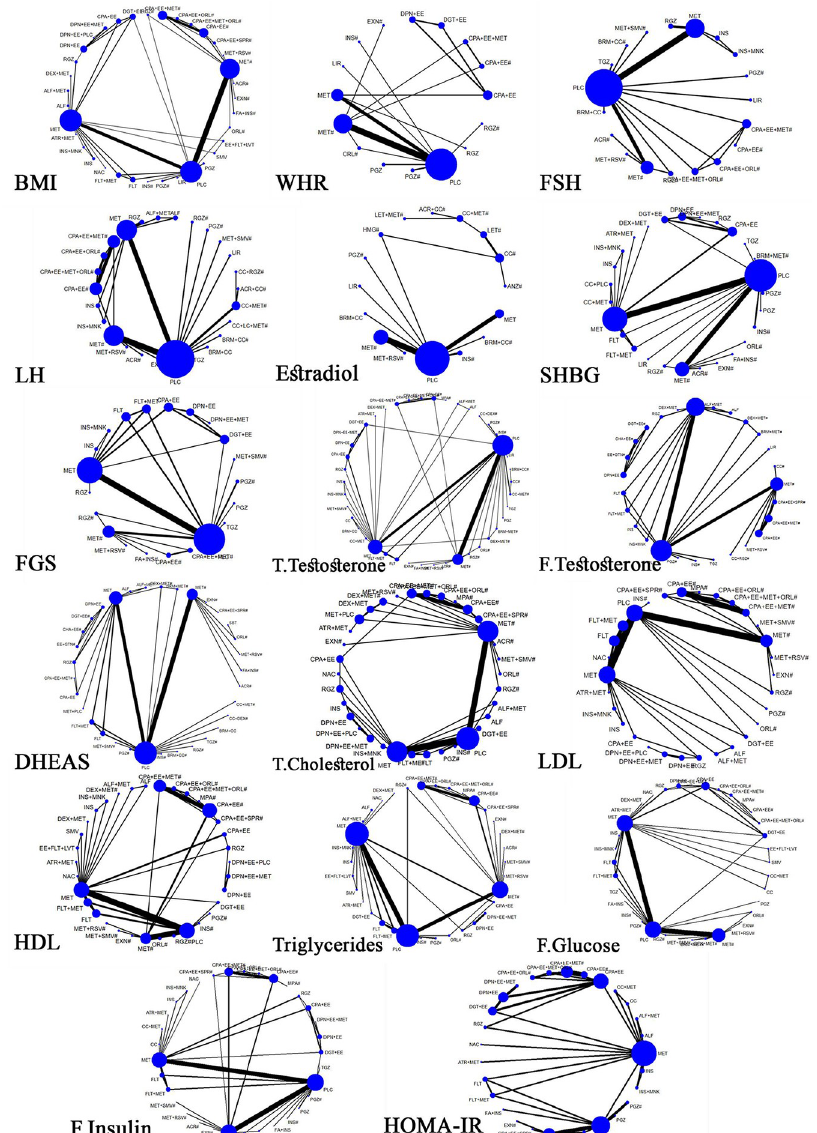
Fig 2. Network graphs of eligible comparisons for efficacy. The size of the circles is proportional to sample size, and the width of lines is proportional to the number of trials. Interventions: acarbose (ACR), alfacalcidol (ALF), anastrozole (ANZ), clomiphene citrate (CC), exenatide (EXN), folic acid (FA), flutamide (FLT) pure follicle-stimulating hormone (FSH), human menopausal gonadotropins (HMG), inositol (INS), letrozole (LET), liraglutide (LIR), metformin (MET), medroxyprogesterone acetate (MPA), N-acetyl cysteine (NAC), orlistat (ORL), pioglitazone (PGZ), placebo (PLC), rosiglitazone (RGZ), sibutramine (SBT), simvastatin (SMV), and troglitazone (TGZ). Acarbose+clomiphene citrate (ACR+CC), alfacalcidiol+metformin (ALF+MET), atorvastatin+metformin (ATR+MET), bromocriptine+clomiphene citrate (BRM+CC), bromocriptine+metformin (BRM+MET), clomiphene citrate+dexamethasone (CC+DEX), clomiphene citrate+ketoconazole (CC+KTZ), clomiphene citrate+l-carnitine (CC+LC), clomiphene citrate+l-carnitine +metformin (CC+LC+MET), clomiphene citrate+metformin (CC+MET), clomiphene citrate+N-acetylcysteine (CC +NAC), clomiphene citrate+rosiglitazone (CC+RGZ), chlormadinone acetate+ethinylestradiol (CHA+EE), cyproterone acetate+ethinylestradiol (CPA+EE), cyproterone acetate+ethinylestradiol+metformin (CPA+EE+MET), cyproterone acetate+ethinylestradiol+metformin+orlistat (CPA+EE+MET+ORL), cyproterone acetate+ethinylestradiol+orlistat (CPA+EE+ORL), cyproterone acetate+ethinylestradiol+spironolactone (CPA+EE+SPR), dexamethasone+metformin (DEX+MET), desogestrel+ethinylestradiol (DGT+EE), drospirenone+ethinylestradiol (DPN+EE), drospirenone +ethinylestradiol+metformin (DPN+EE+MET), ethinylestradiol+flutamide+levonorgestrel (EE+FLT+LVT), ethinylestradiol+gestodene (EE+GTN), ethinylestradiol+metformin+norgestimate (EE+MET+NRG), ethinylestradiol +norgestimate (EE+NRG), folic acid+inositol (FA+INS), flutamide+metformin (FLT+MET), human menopausal gonadotropins+ leuprolide (HMG+LPR), inositol+monacolin k (INS+MNK), letrozole+metformin (LET+MET), metformin+rosuvastatin (MET+RSV), and metformin+simvastatin (MET+SMV).